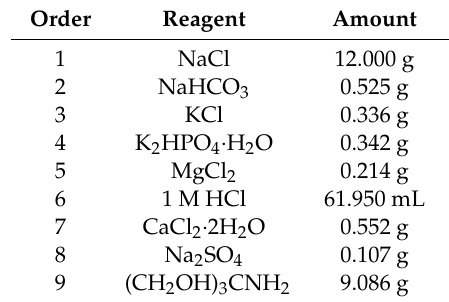
Table 2. Reagents for preparing SBF (pH 7.40, 1.5 L)